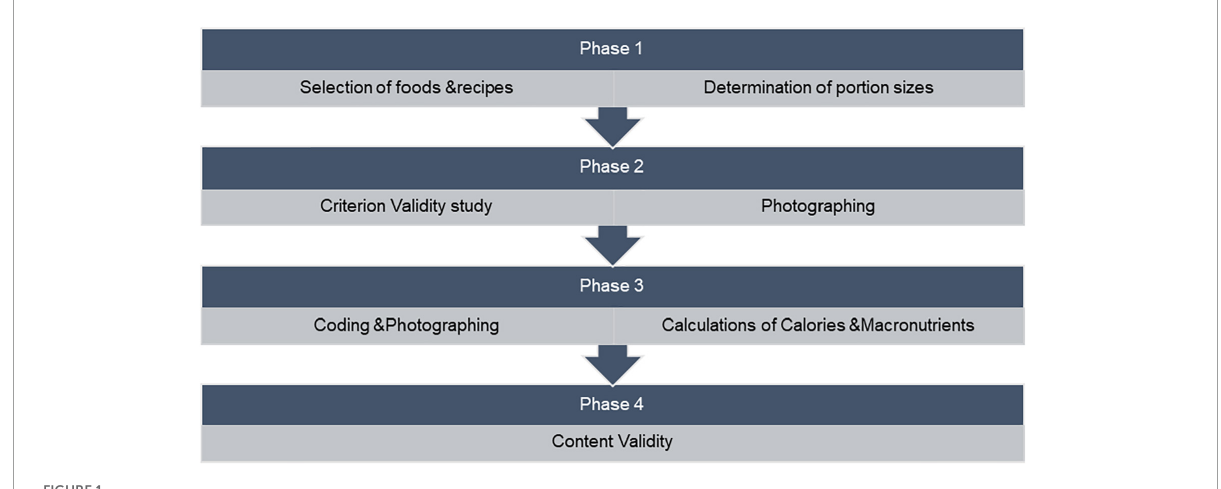
FIGURE1 Phases of the development and validation of photographic food